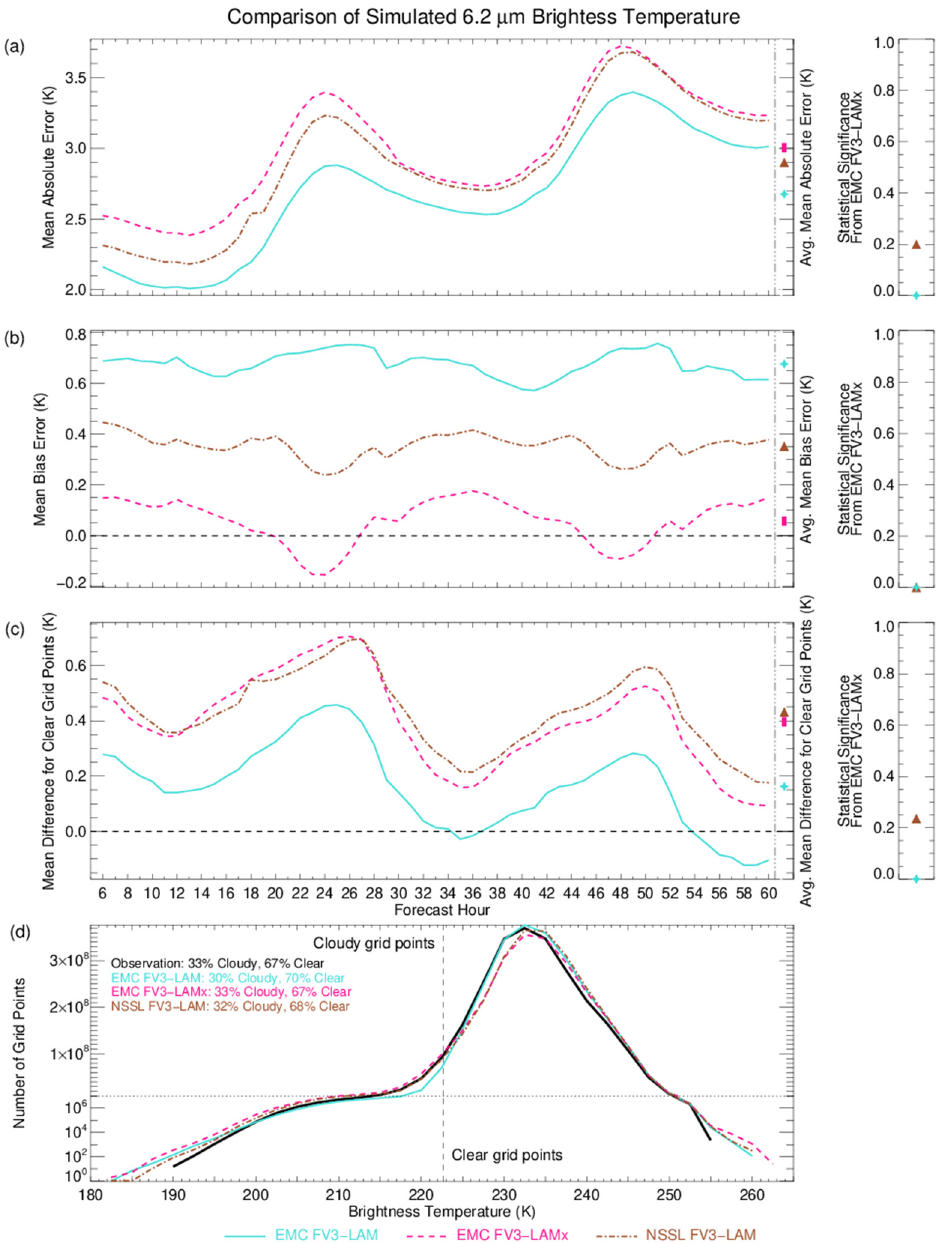
Figure 3. As in Figure 2, but using configurations employed during the 2020 Hazardous Weather Testbed. The statistical significance in ( a – d ) is calculated compared to EMC FV3 ‐ LAMx.